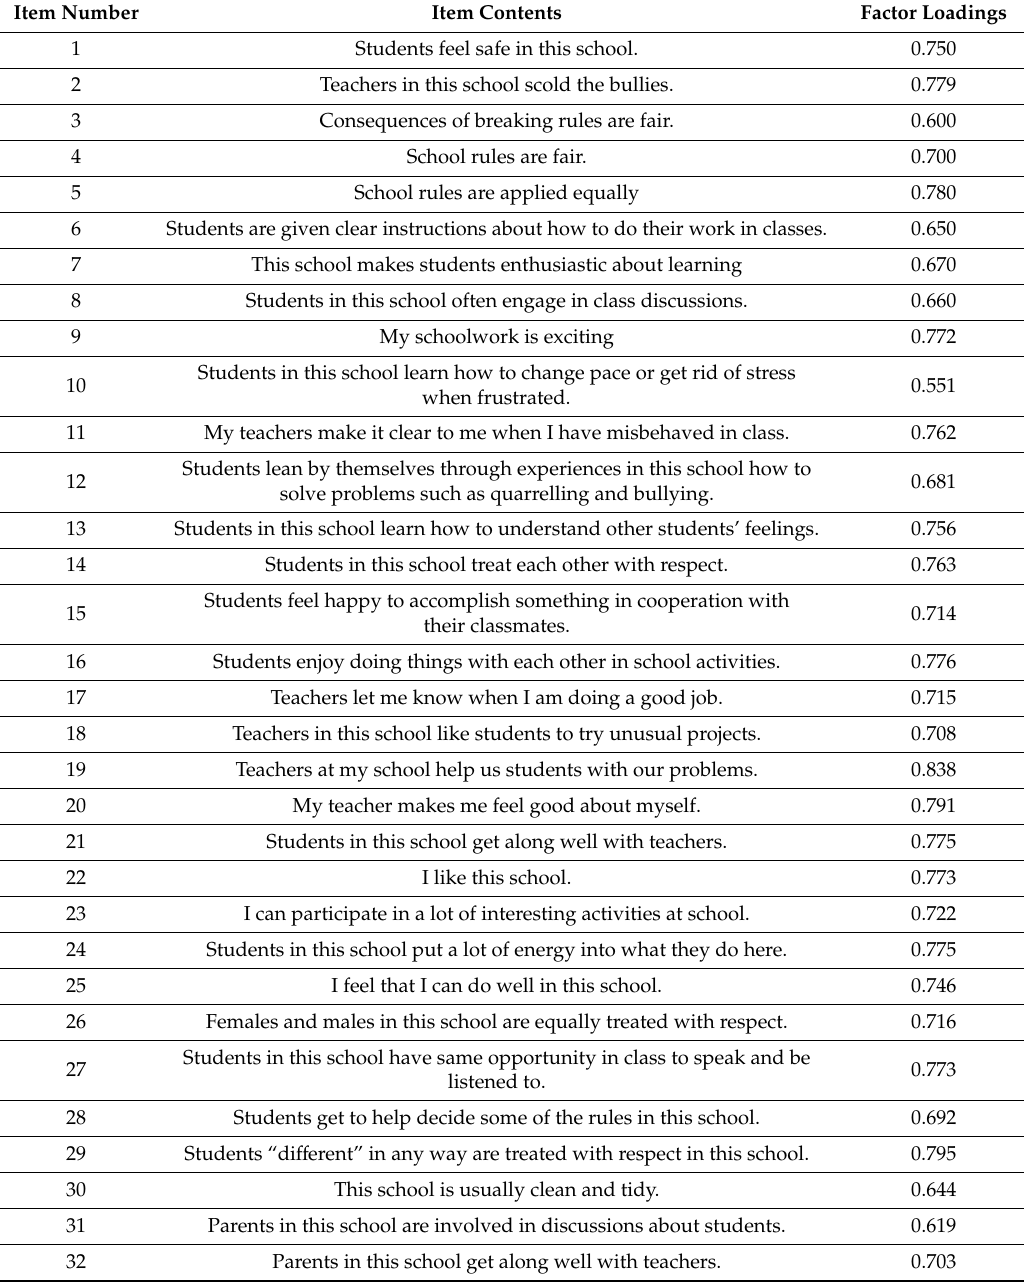
Table 2. Geomin factor loadings of exploratory factor analysis in each